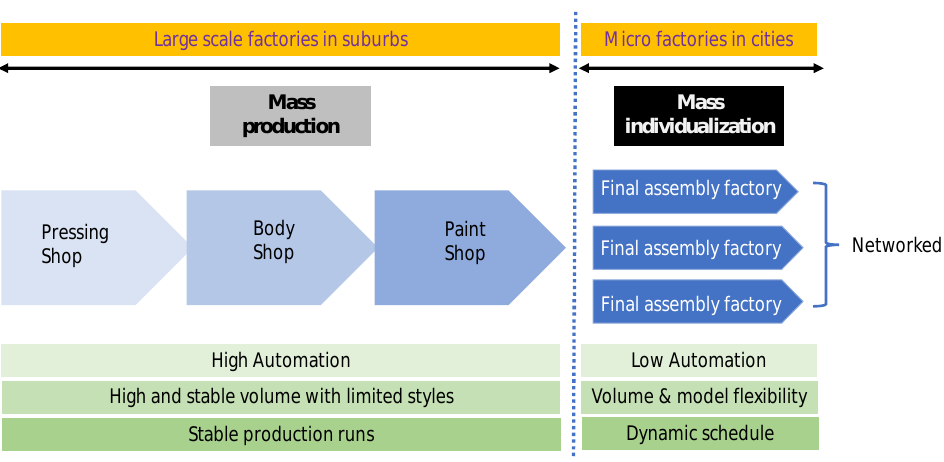
Figure 1. A new car manufacturing value chain expected to come with mass individualization. Figure 1. A new car-manufacturing value chain expected to come with mass